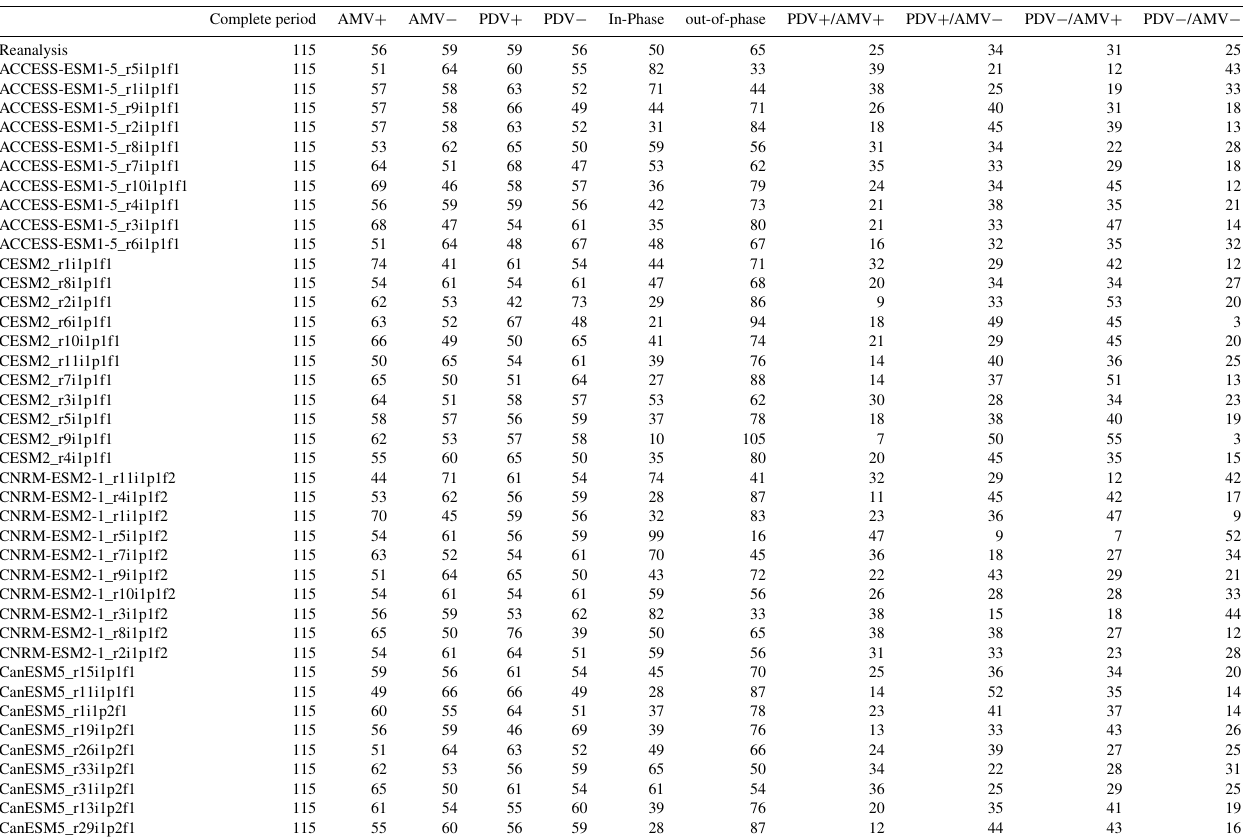
Table A4. Number of years for every regime for reanalysis and CMIP6 simulations